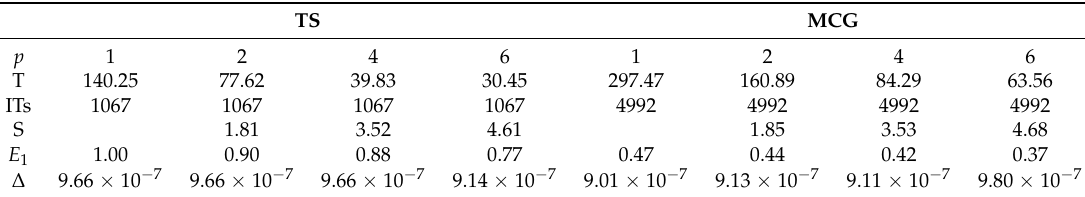
Table 5. Numerical results of Example 2 with h =